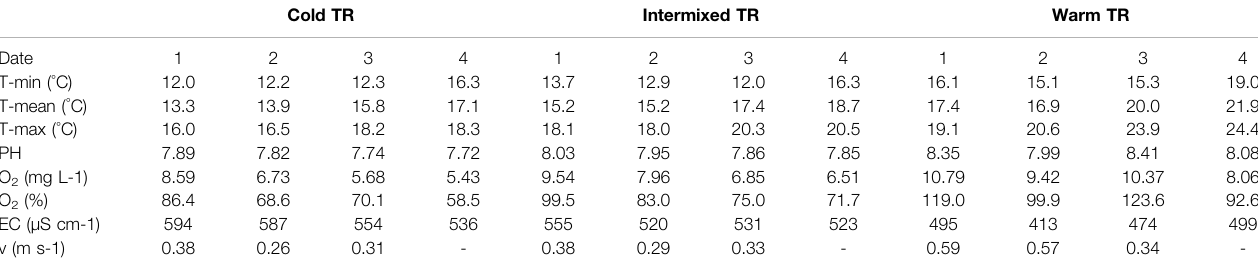
TABLE 2 | Abiotic water parameters measured at the thermal regions (TR) during the study. Cold TR Intermixed TR Warm